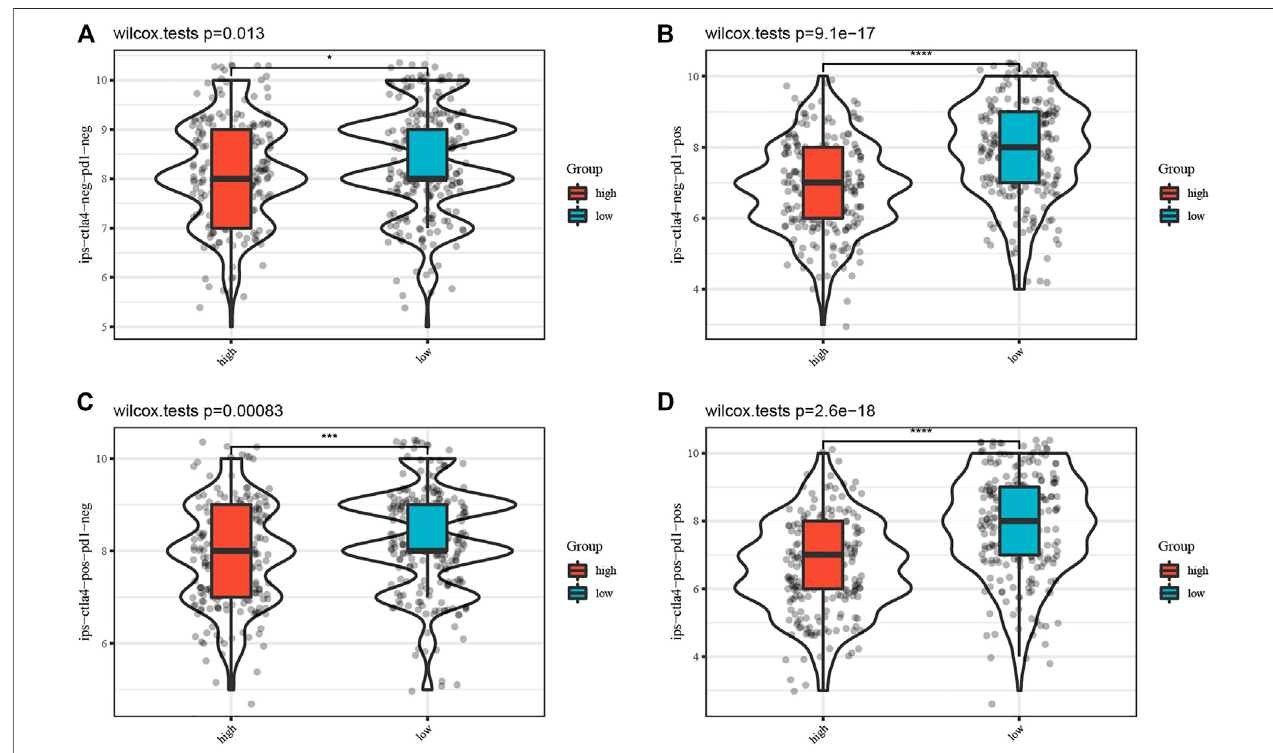
FIGURE 7 | Comparison of the IPS between the high-risk and low-risk groups. Each fi gure of (A – D) shows the signi fi cant difference of four kinds of immunophenoscore (IPS) between the high-risk group and low-risk group.